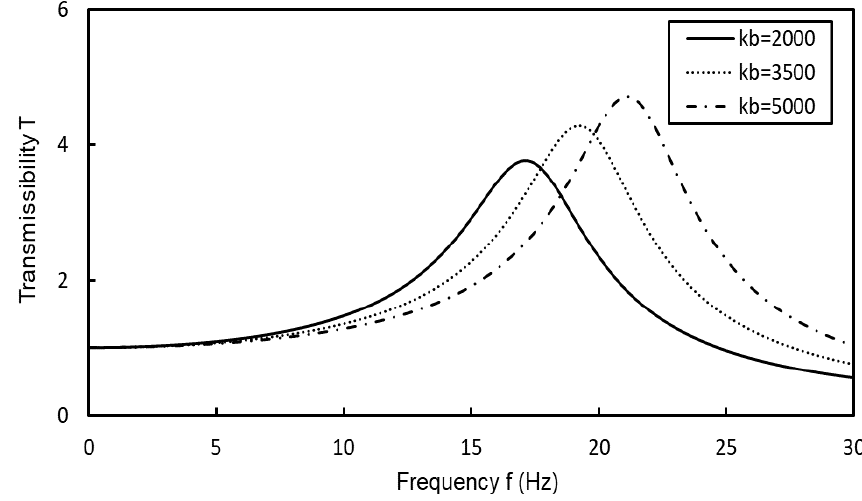
Figure 10. Transmissibility of the non-linear stiffness isolator module of VEAM with varying values of k b .